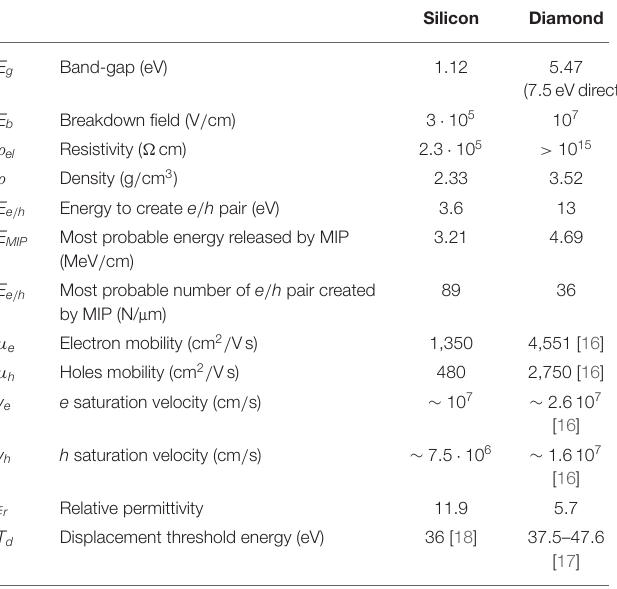
TABLE 1 | Physical properties of silicon and diamond at room temperature [31].